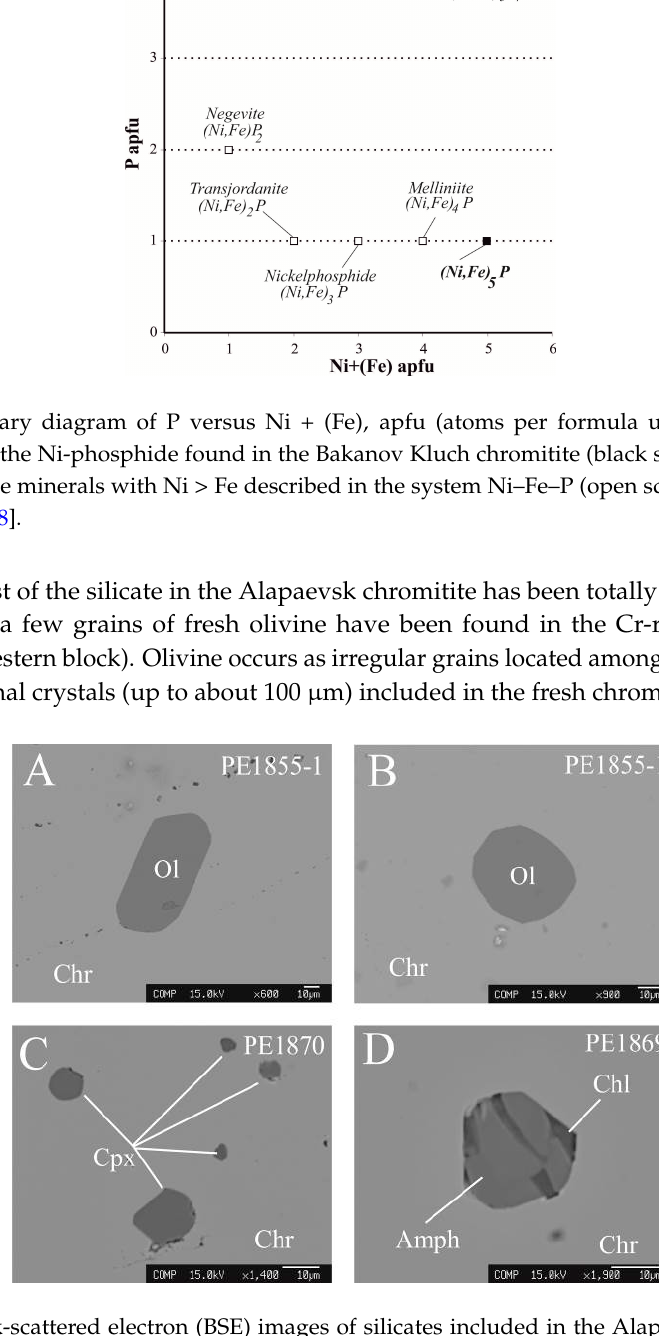
Figure 12. Back-scattered electron (BSE) images of silicates included in the Alapaevsk chromitites. Polygonal olivine in the chromitite from Kurmanovskoe ( A , B ); grains of clinopyroxene in the chromitite from Bakanov Kluch ( C ); inclusion composed of amphibole and chlorite found in the chromitite form 3-d Podyony Rudnik ( D ). Abbreviations: Ol = olivine; Cpx = clinopyroxene; Amph = amphibole; other abbreviations = see Figures 7 and 8.